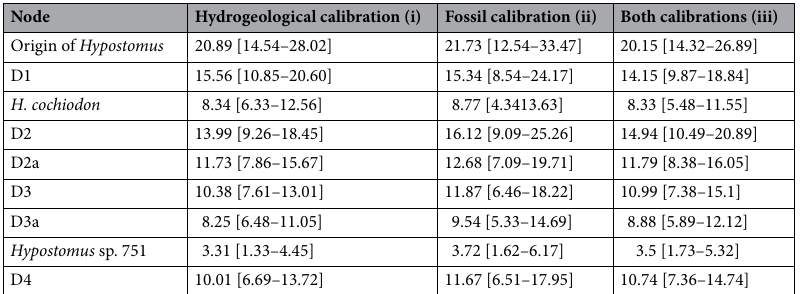
Table 2. Inferred ages and 95% confidence intervals (between brackets) of the Highest Posterior Density (HPD) of selected nodes of the Hypostomus phylogenetic tree. Three calibration analyses were performed using: (i) two dated hydrogeological events; (ii) a dated fossil; and (iii) the ages of the two hydrogeological events and the fossil. The details of the calibration points are presented in the main text. The names of the nodes are given in the main text and in Fig.